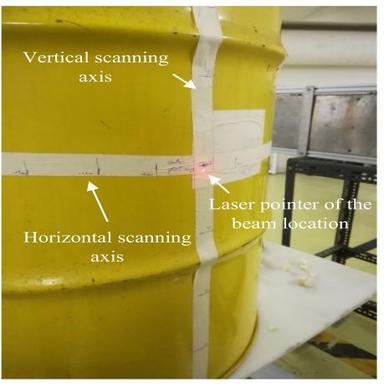
Mock-up drum positioning geometry.